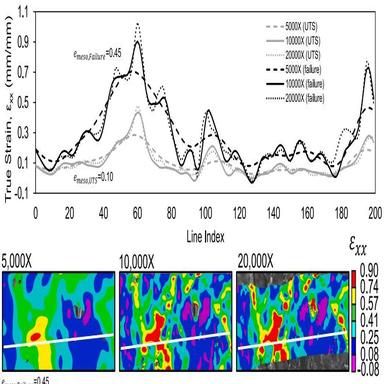
μDIC analysis for DP980GI at 5,000×, 10,000×, and 20,000×. The contour image is taken at emeso,failure and the white line is the scan line used to produce the strain distribution plot.